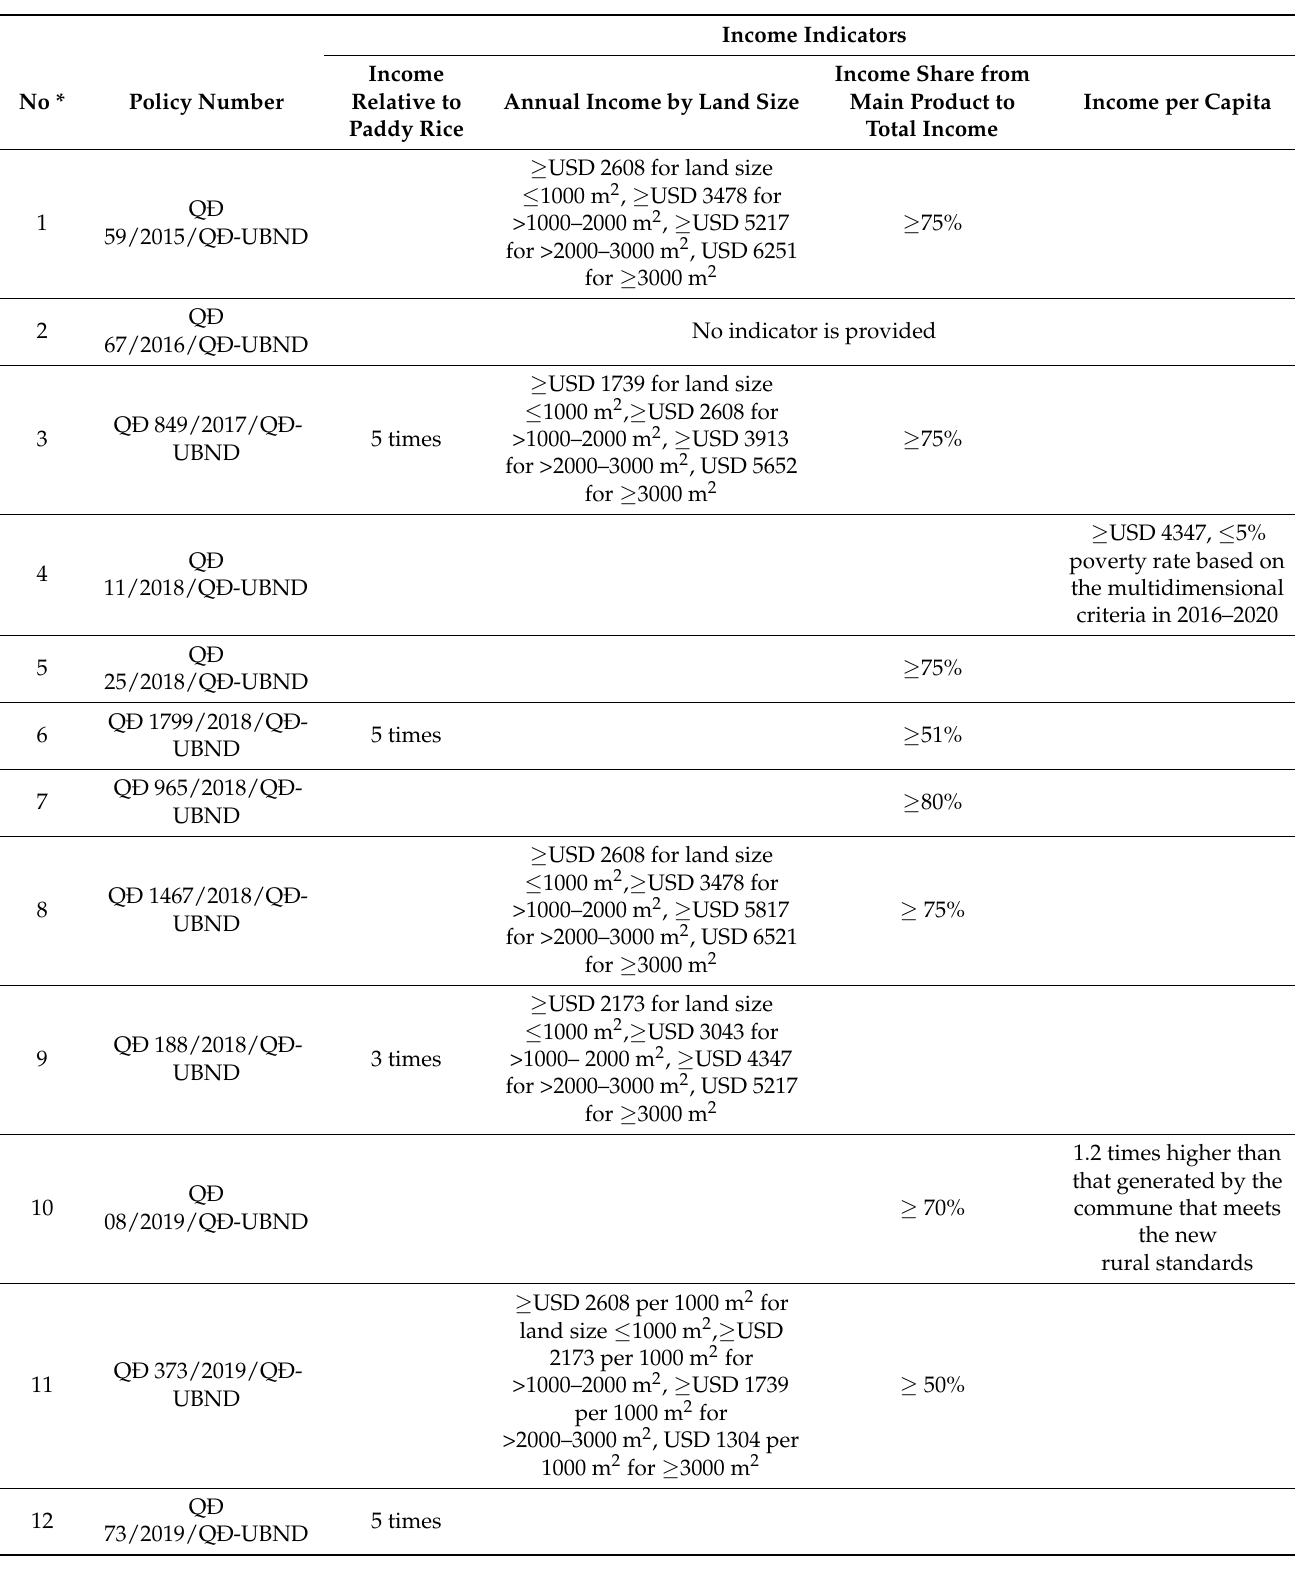
Table A3. Income indicators used in the home garden